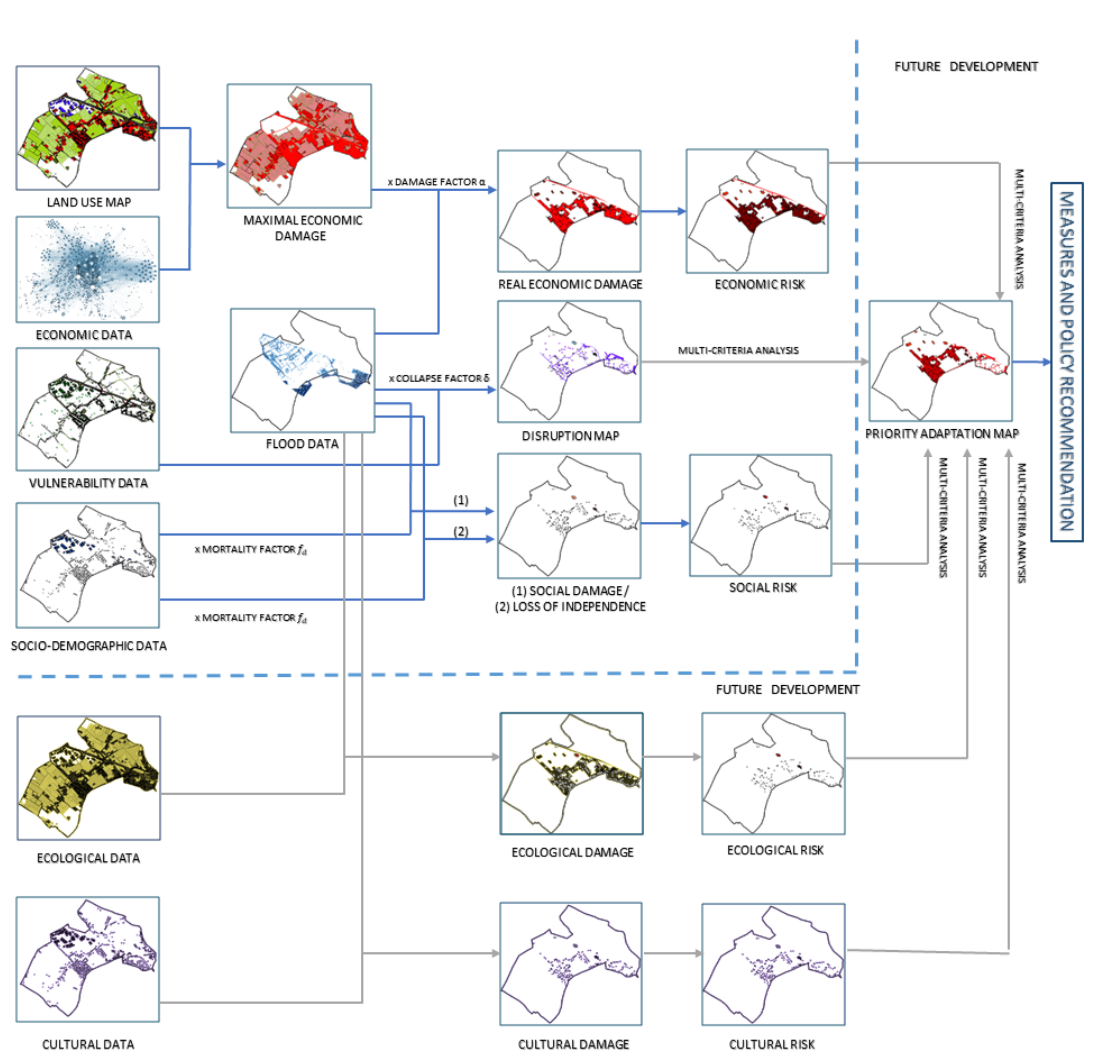
Figure 7. FLIAT methodology, with the indication of future development (ecological and cultural damage and risk calculation and the addition of the development of a priority adaption map methodology).